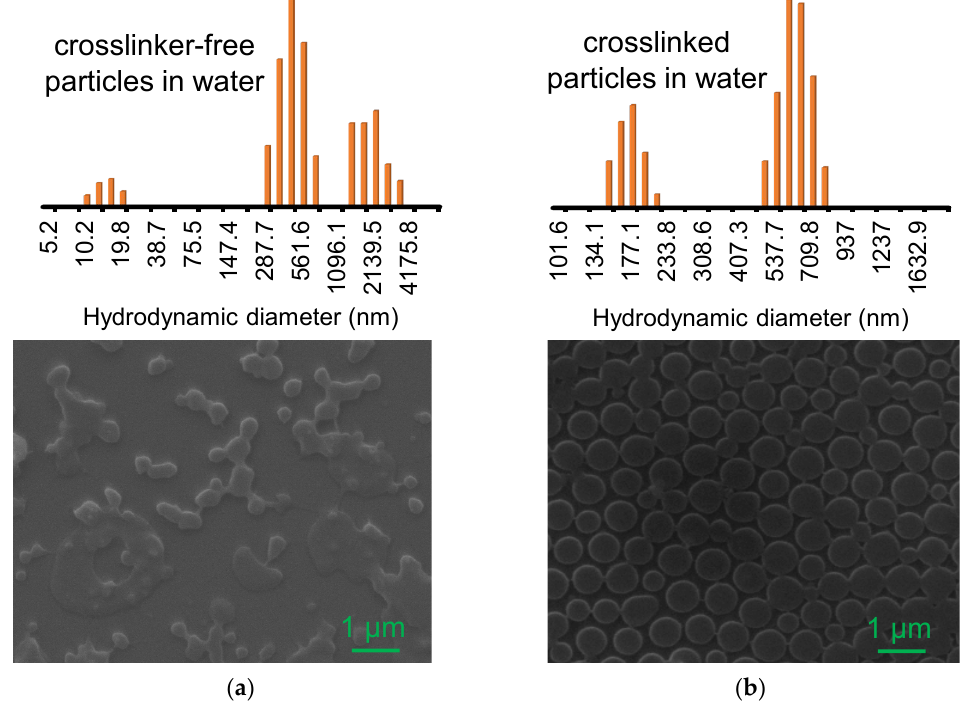
Figure 1. SEM image of ( a ) crosslinker-free and ( b ) crosslinked PNIPAM particles and their corresponding size distribution by DLS.